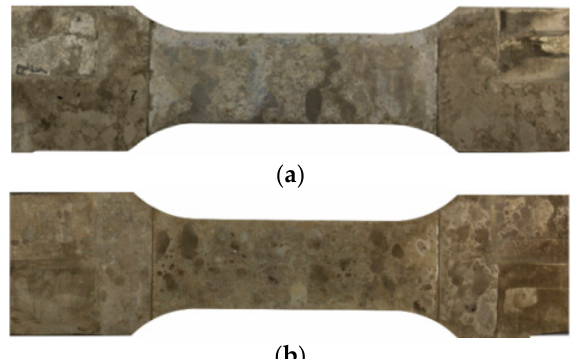
Figure 17. Visual inspection of EN AW-5754 specimens after ( a ) salt spray test and ( b ) cyclic climate change tests.